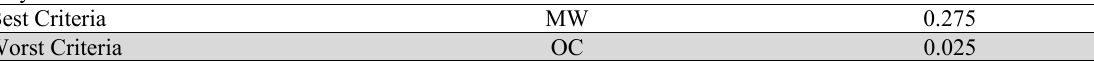
Fuzzy Best and Worst Criteria Best